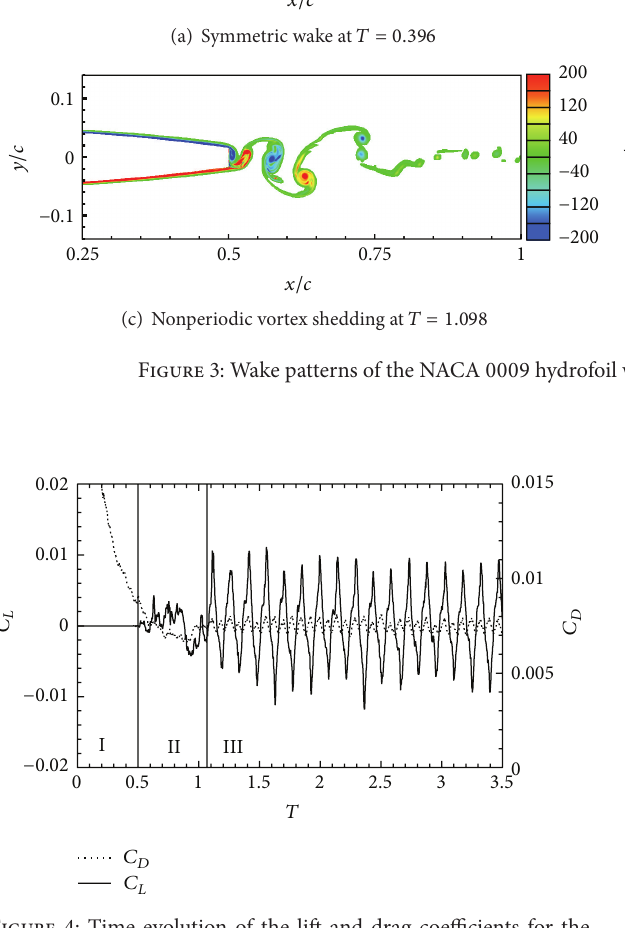
Figure 4: Time evolution of the lift and drag coefficients for the impulsively started NACA 0009 hydrofoil with a truncated trailing edge ( 𝛽 = 0 ∘ ) at Re = 10 6 . Regime I denotes the developing regime of a symmetric wake, II a symmetry-breaking transition, and III periodic vortex